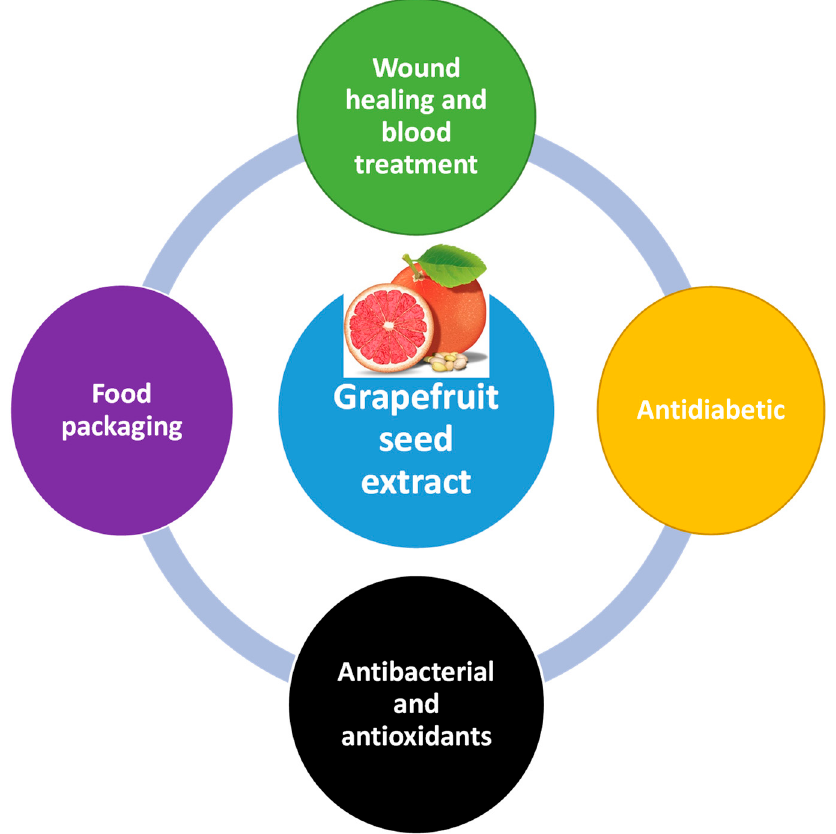
Figure 1. Biological properties and food applications of GSE.